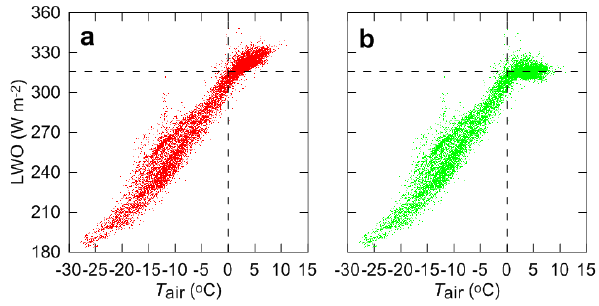
Figure 2. Half-hourly values of LWO as a function of T air , (a) be- fore and (b) after applying the correction for T air above 0 ◦ C. The dashed lines indicate 0 ◦ C and 315.6Wm − 2 , the maximum LWO for a melting